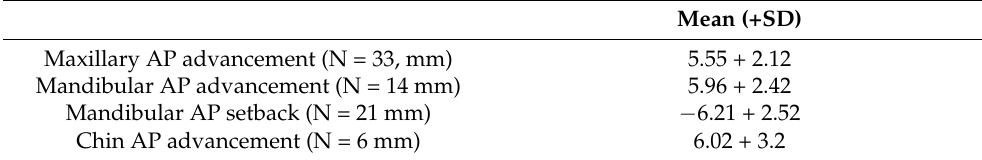
Table 2. Surgical hard tissue movement measurements.